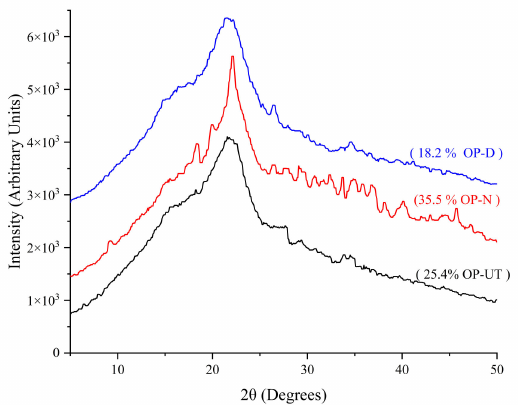
Figure 6. XRD patterns of the untreated and treated fillers.